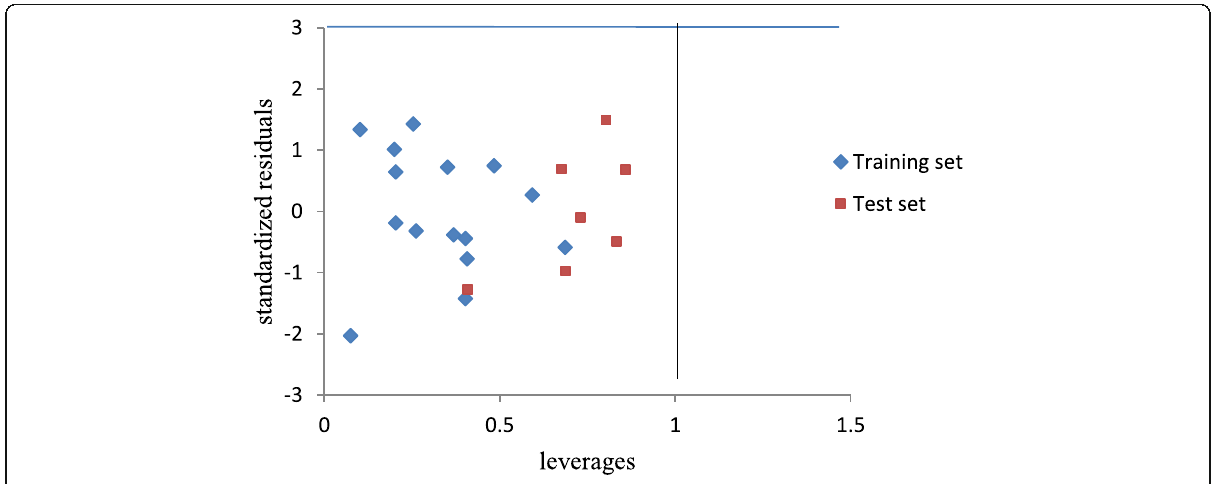
Fig. 3 Plot of the standardized residuals against the leverages (Williams